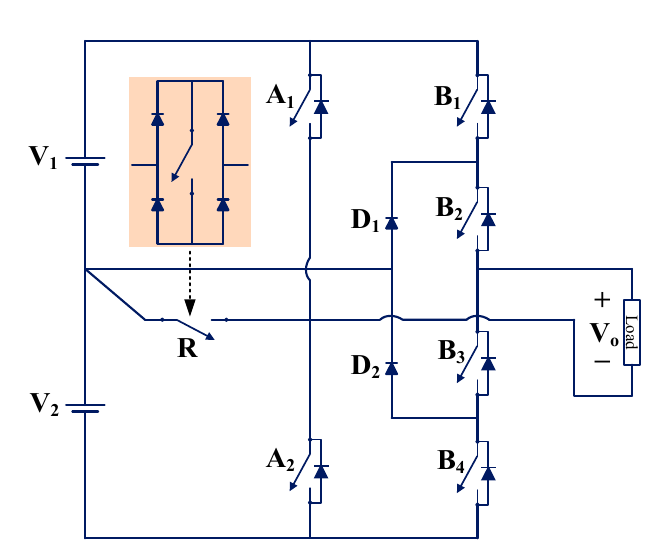
Figure 16. Single-phase five-level FT MLI (TP17) [8].